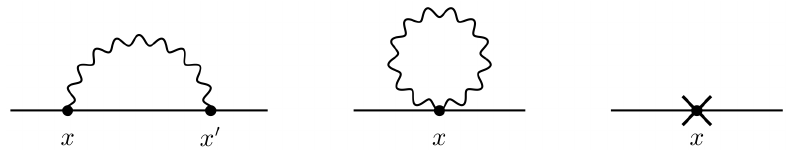
Figure 2 . 1-graviton loop contributions to − iM 2 ( x ; x 0 ) corresponding to the three terms of expression (2.4). Graviton lines are wavy, scalar lines are straight and counterterms are denoted by a